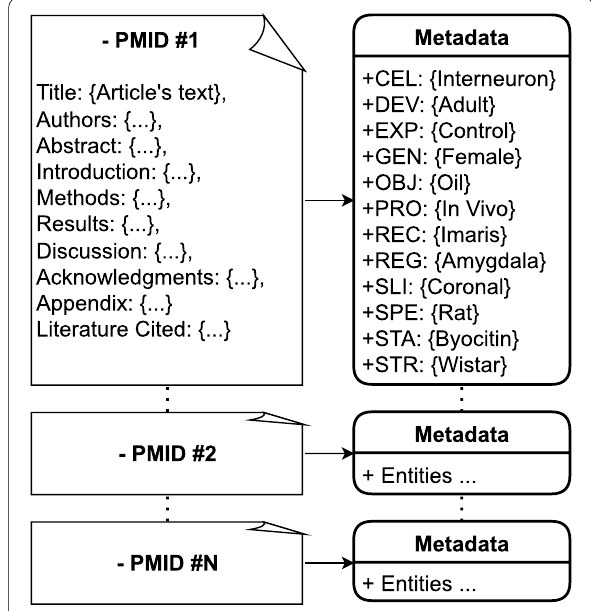
Fig. 2 Schematic representation of the data for the metadata extraction task. Unstructured text of neuroscience articles are mapped to their corresponding metadata matching the NeuroMorpho.Org schema. Each article has a body of text extracted from PubMed or other publishers and is associated with a list of target metadata entities. The task of the algorithm is to find the target entities in the text of the article and create a list of suggestions ranked based on their relevancy